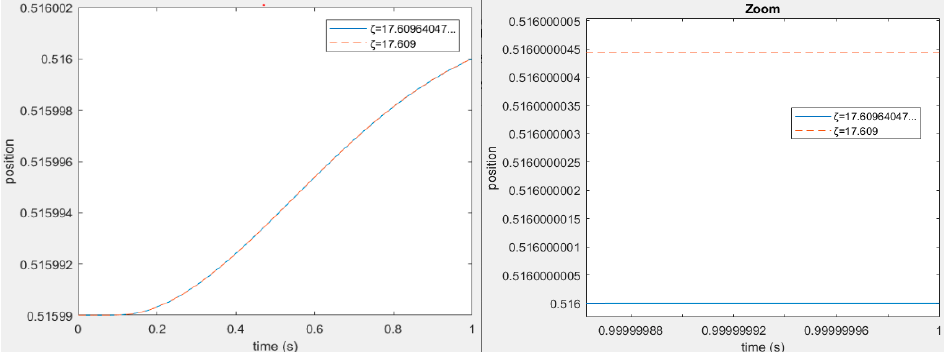
Figure 7. Two different results of trajectory to compare the final value of the trajectory, using three decimals and many decimals. On the right side of the figure, an approach is presented to observe the difference between the two final results obtained.